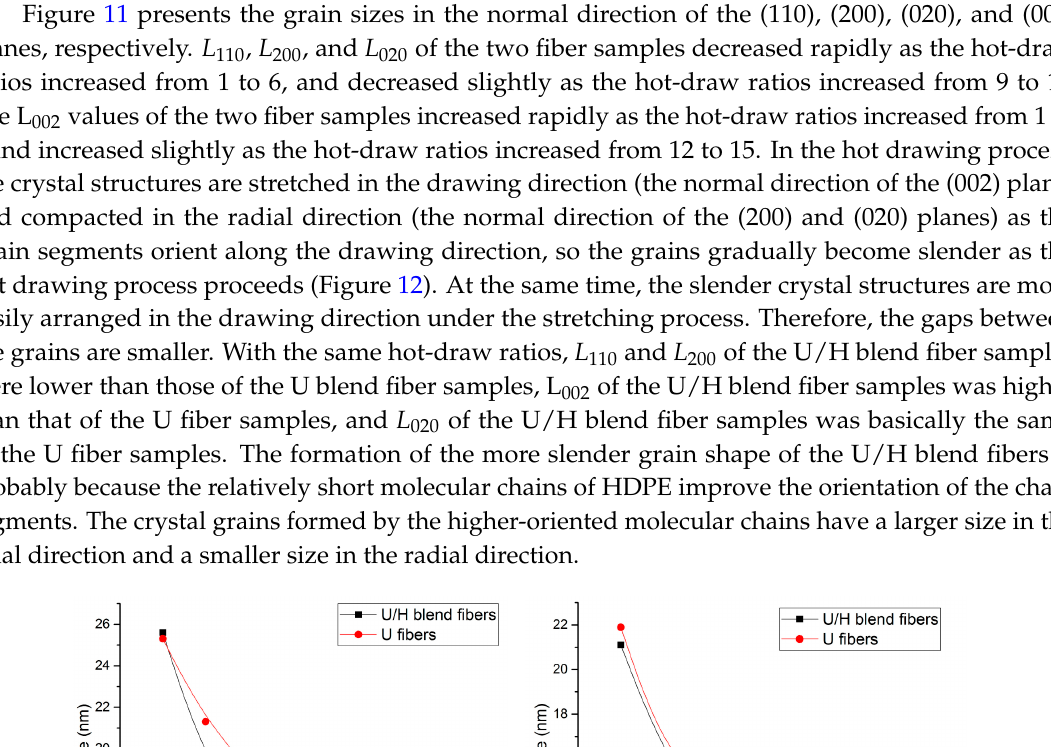
( d ) Figure 11. The grain size of the fiber samples: ( a ) (110) plane; ( b ) (200) plane; ( c ) (020) plane; and ( d ) (002) plane.